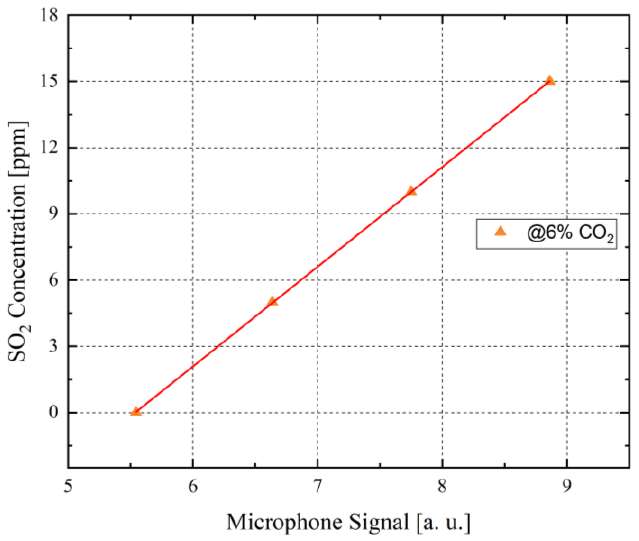
Figure 11. The microphone signal in relation to the set SO 2 concentrations at a constant CO 2 concentration of 6 vol.-%, using pre-calibrated mass flow controllers to conduct these measurements in the laboratory. The detected microphone signals and the set SO 2 concentrations show a clear linear relation. An increase of the SO 2 concentration increases the corresponding microphone signal. This graph is used as a reference to estimate the measured SO 2 concentration from the detected microphone signal during the field test.